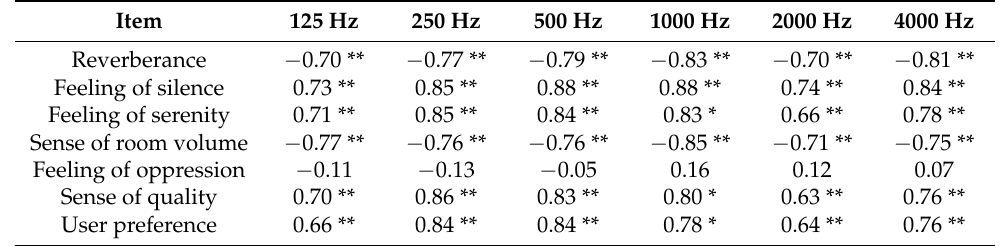
Table 9. Correlation coefficients between the average sound absorption coefficient and psychological value of each evaluation